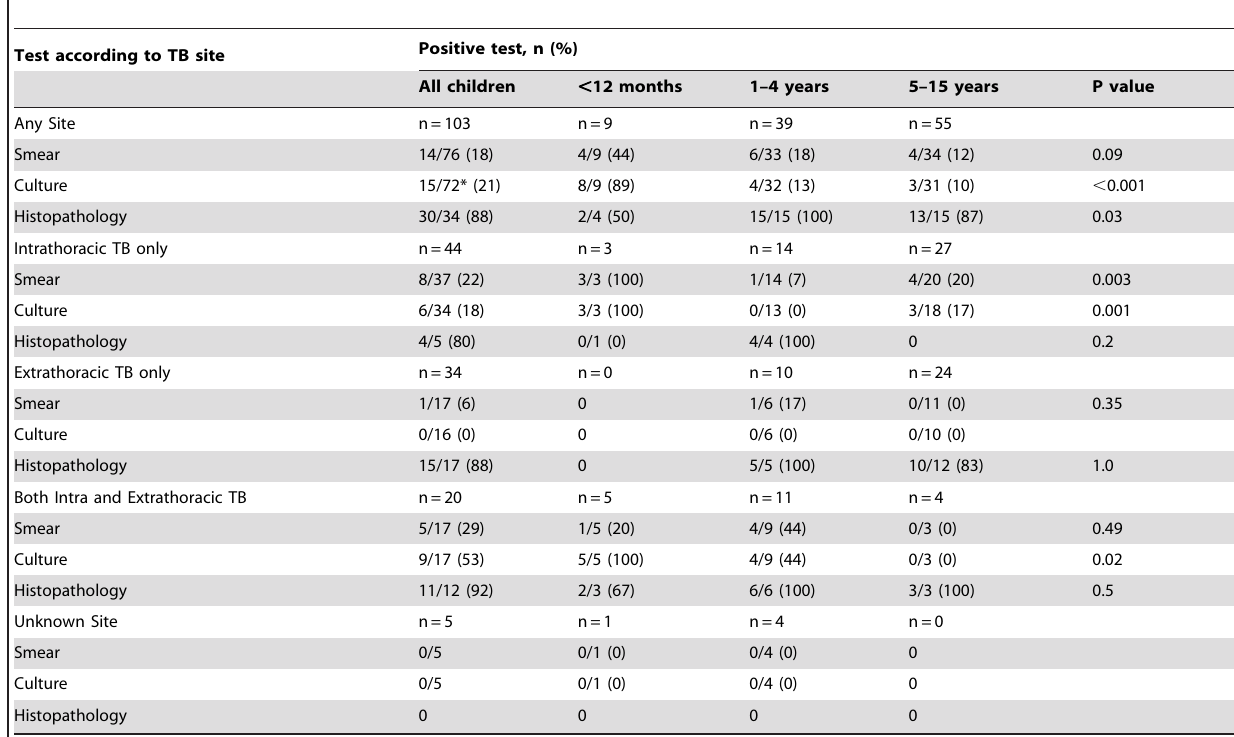
Table 5. Microbiologic and Histopathologic Results According to Site of TB Infection and